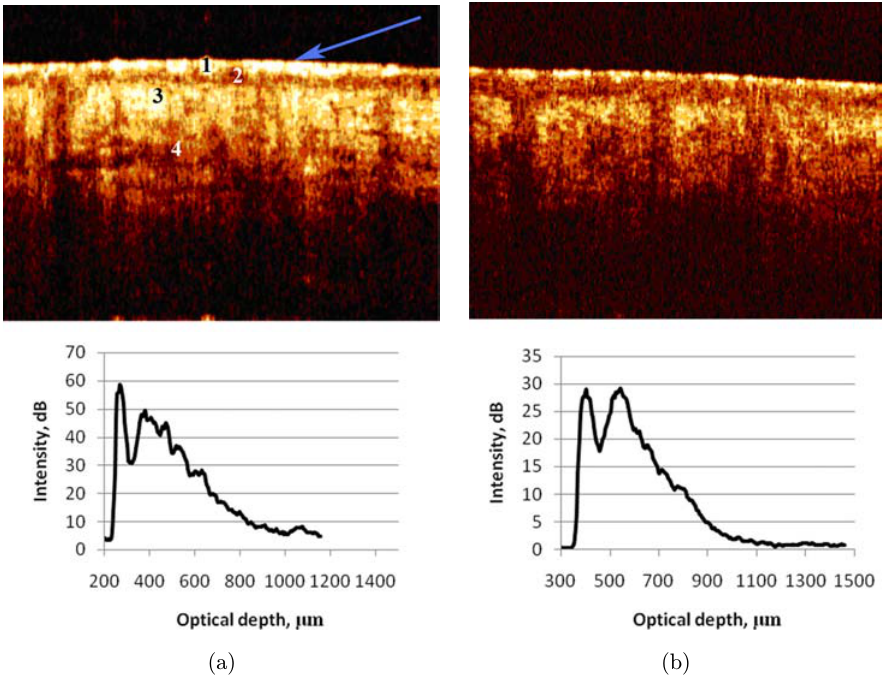
Fig. 1. OCT images and averaged A-scans of skin localized at the face (cheek bone) of a 13-days old newborn (a) and a teenager 14 years old